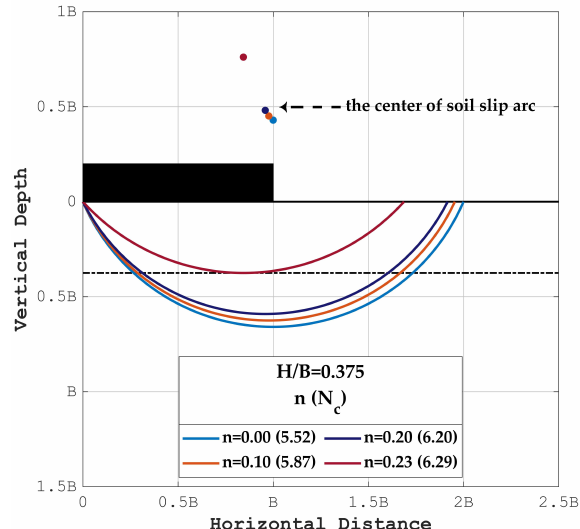
Figure 12. Slip surfaces shrink with the increasing n for S u , bot / S u , top > 1.